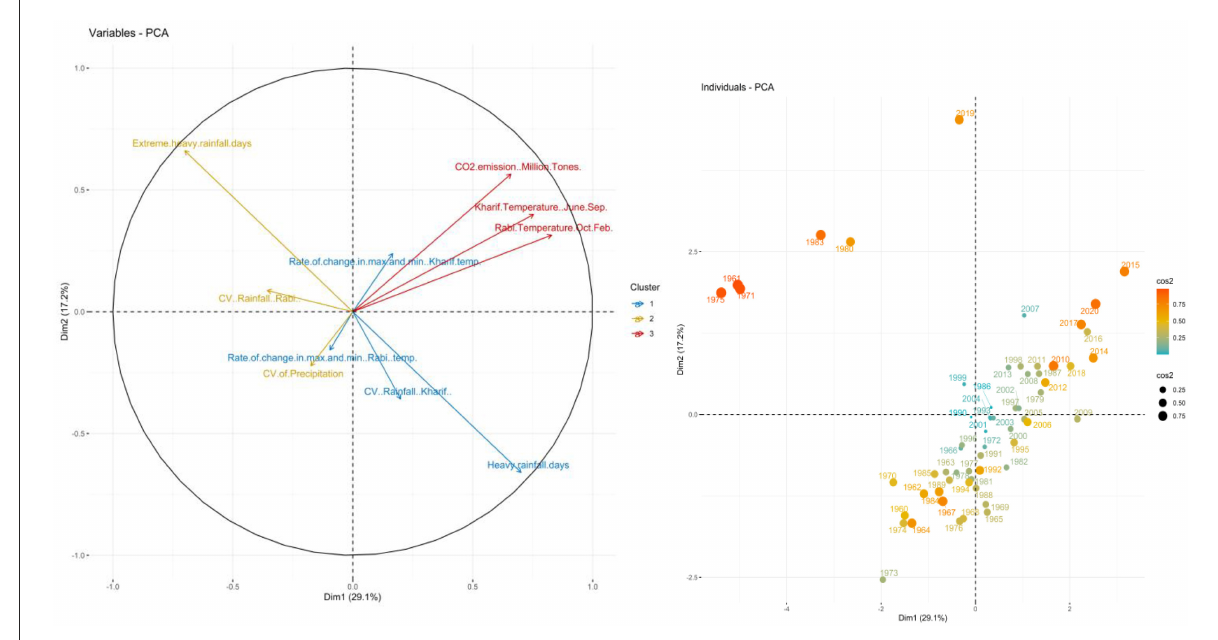
FIGURE6 Biplot between PC1 and PC2 and principal scatter plot of past six decades under exposure indicators.